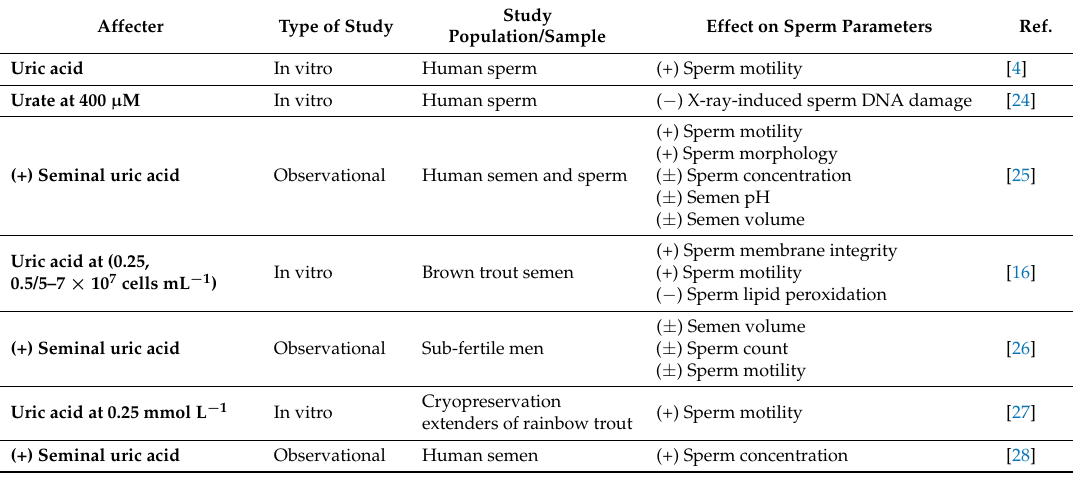
Table 1. Studies that demonstrate the direct effect of uric acid on semen and sperm